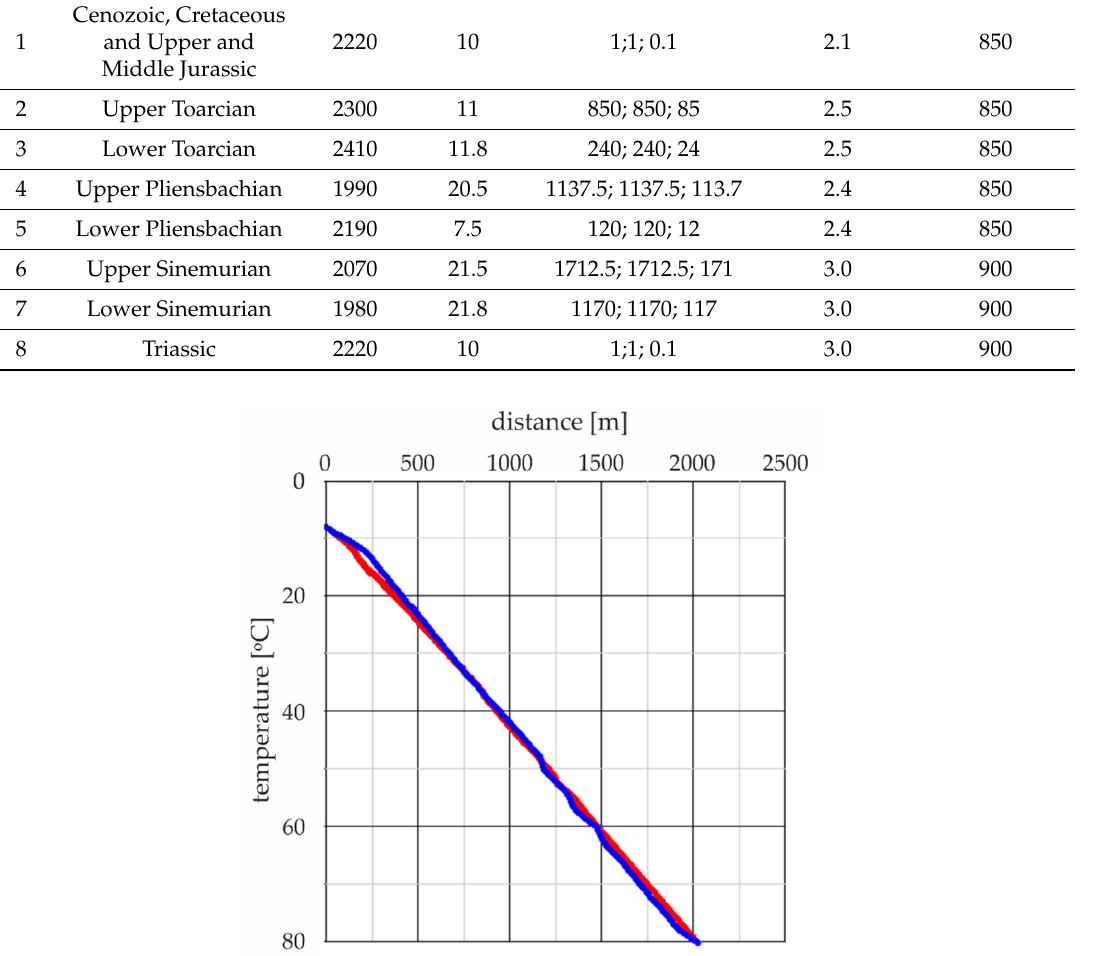
Figure 4. Results of calibration of numerical model. Red line—the measured value for the Choszczno IG-1 well, blue line—the estimated value.